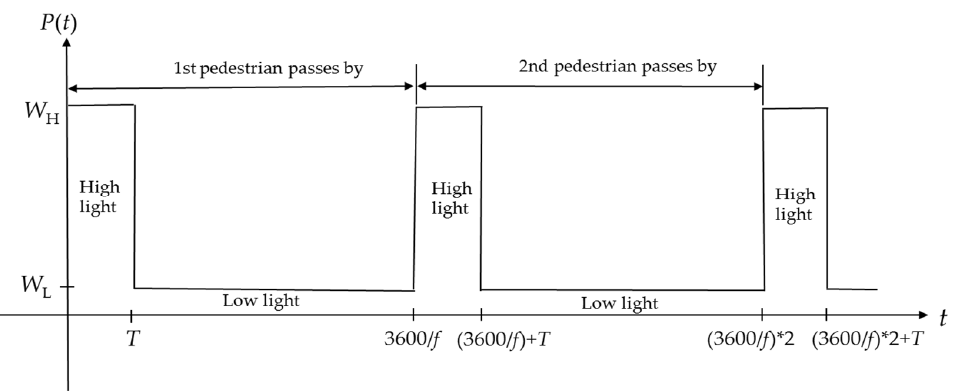
Figure 11. Power changes in high-light mode and low-light mode.